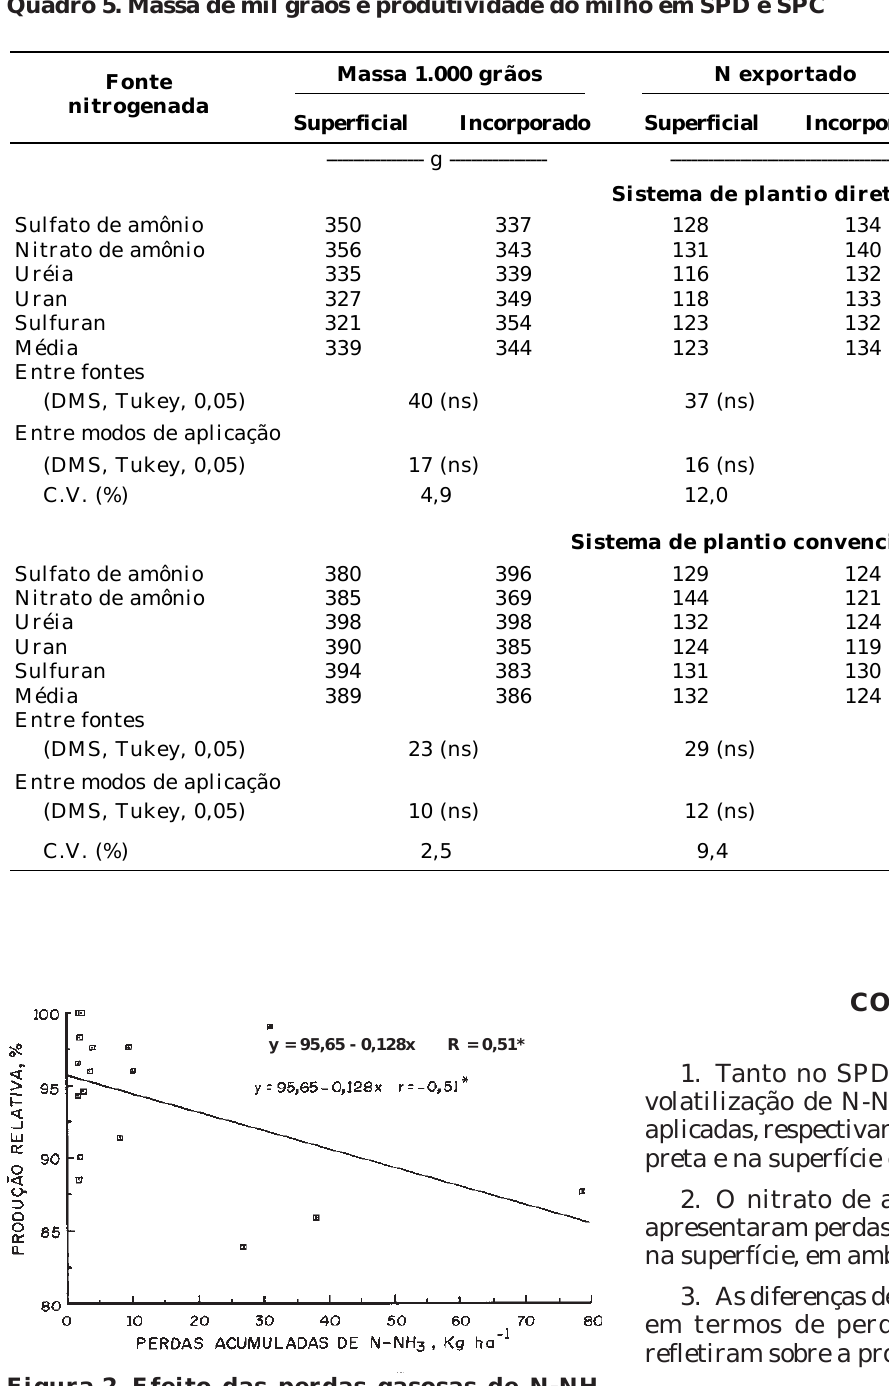
Figura 2. Efeito das perdas gasosas de N-NH 3 volatilizado sobre a produtividade relativa do milho no SPD e